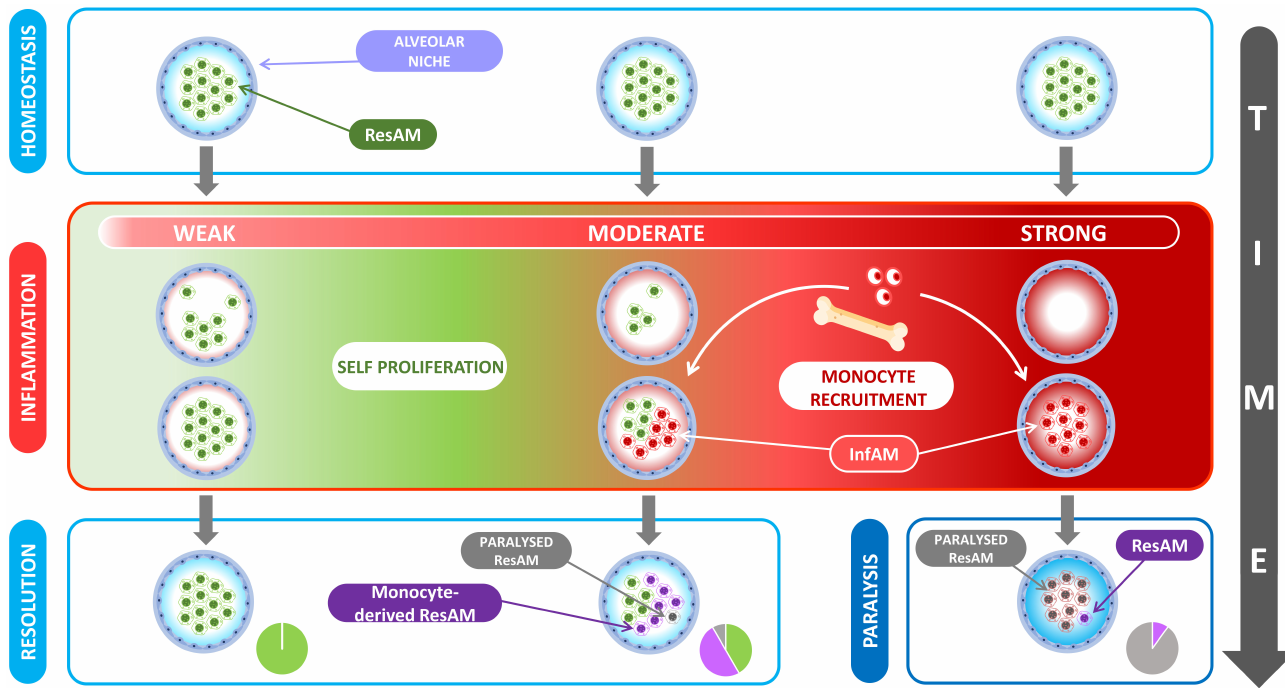
Figure 4. Role of the stimulus intensity and AM niche organization. During a weak intensity inflammation, the ResAM depletion is scarce and the remaining ResAM can repopulate the niche by self-proliferation without the contribution of circulating monocytes. During a moderate intensity inflammation, the ResAM depletion is more important and the self- proliferation is not enough. Circulating monocytes are recruited and differentiate in an inflammatory context into InfAM. At the resolution of the inflammation, the niche is enriched with a new population of ResAM originated from the recruited monocytes and some monocyte-derived AM display a paralyzed phenotype. During a strong intensity inflammation, the alveolar niche is totally depleted and no ResAM are left to self-proliferate. The recruited monocytes differentiate into InfAM and constitute the main population of the niche. At the resolution of the inflammation, the AM are mostly paralyzed as the microenvironment promotes an excessive tolerance leading to a global immune suppression. The intensity of the inflammation is responsible for proportions changes of different cell subtypes in the alveolar